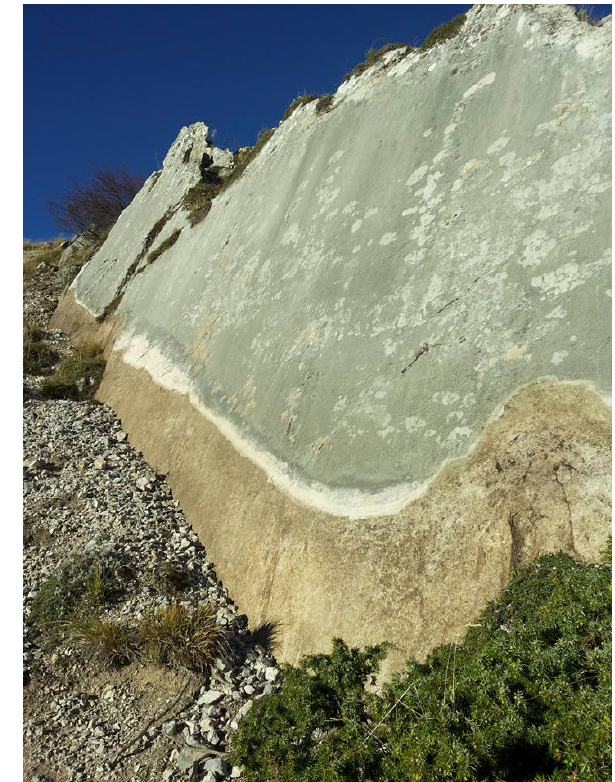
Figure 14. The fault plain (NNW–SSE) exposed for about 2.5m and visible on the southwestern side of Mount Vettore.